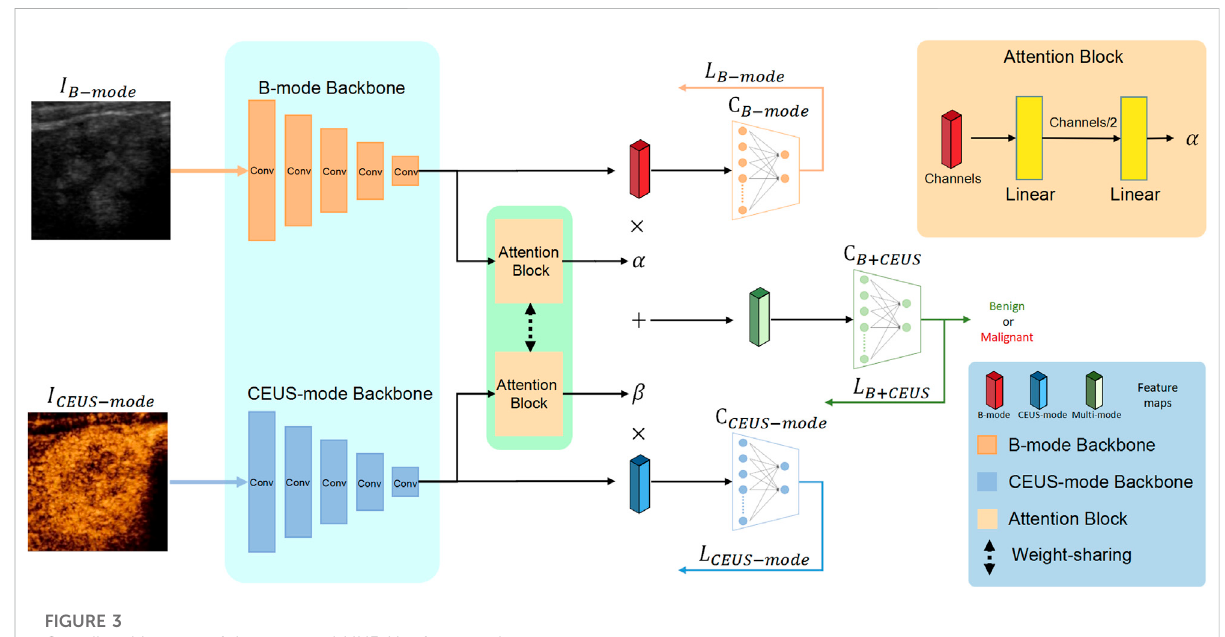
FIGURE 3 Overall architecture of the proposed MUF-Net